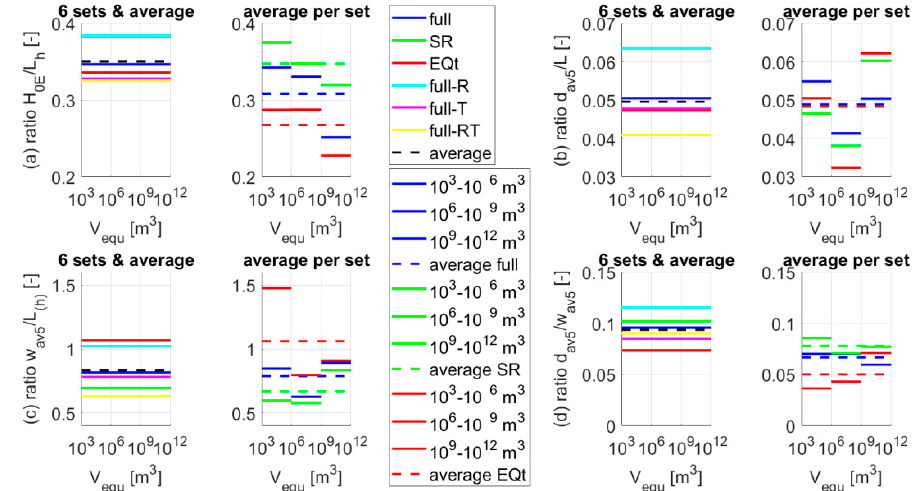
Figure 11. Comparison (H 0E /L h ( a ), d av5 /L ( b ), w av5 /L (h) ( c ), and d av5 /w av5 ( d )) of mean values of ratios (µ) for the six tested sets and the respective average mean value (µ) of this publication (Tables 5 and 6c; left subplots) and of the average of the mean values (µ) per set as presented in Domej et al. [31] (Table 7; right subplots). Table 7. Ratios per volume group as reported in Domej et al. [31]. The value triplets correspond to the ratios per tested set (“full” ( a ), “SR” ( b ), and “EQt” ( c )). Ratios in Domej et al.